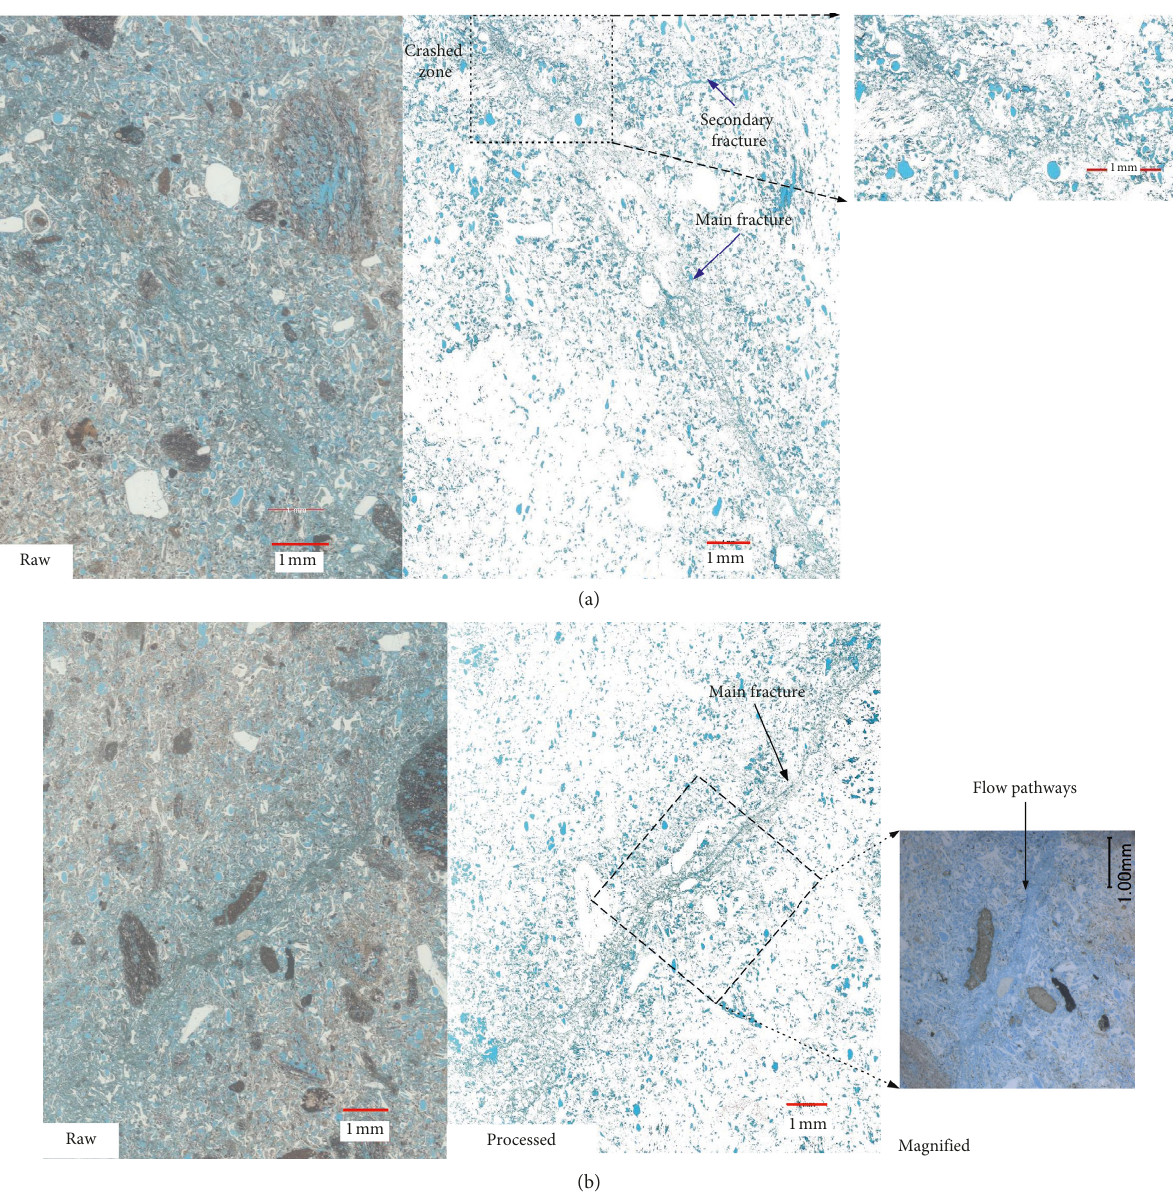
Figure 19: Images of blue resin impregnated thin-section samples after the tests under (a) Δ σ Δ P P � 0.8MPa, P C � 5 MPa, P P � 0.5MPa. Left: original images, middle: processed images to emphasize the blue resin, and right: magnified